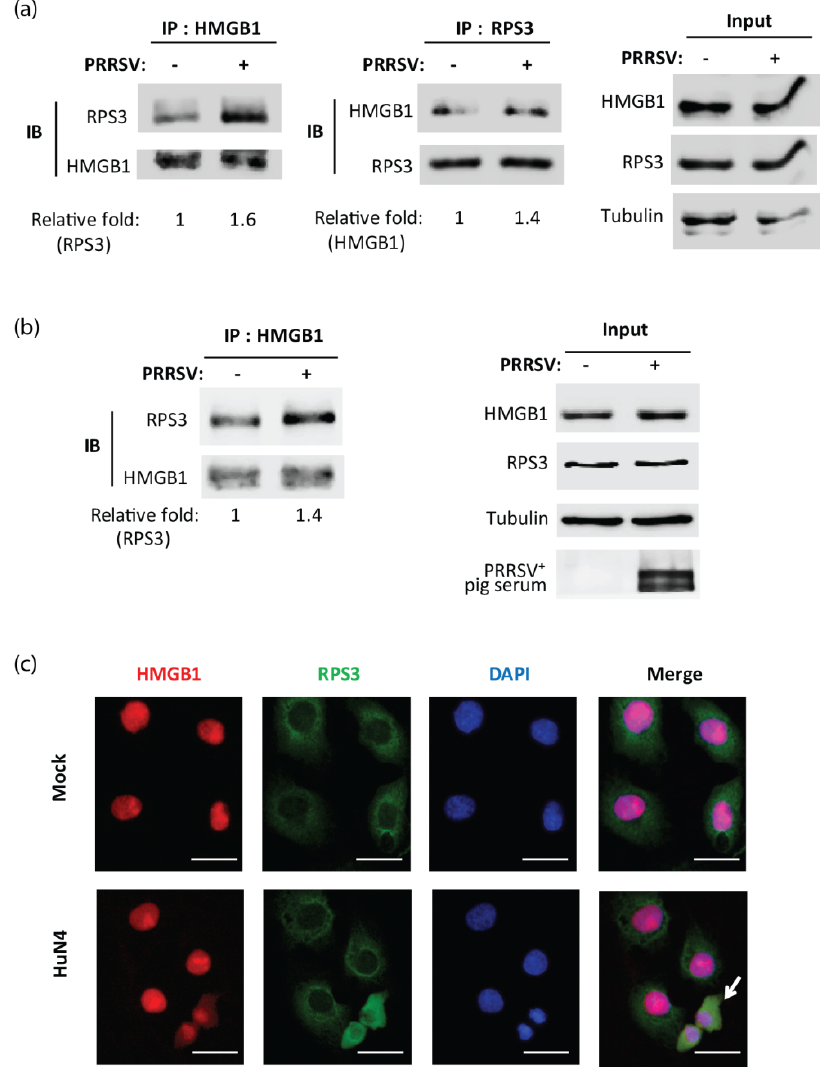
Figure 4. PRRSV increases HMGB1 binding to RPS3 in MARC-145 cells. MARC-145 cells were infected with HuN4 at an MOI of 1 for 6 h ( a ) and 24 h ( b ). The cells were harvested for IP with antibodies against HMGB1 or RPS3, followed by IB. Relative levels of RPS3 and HMGB1 are shown as folds below the images after normalization with HMGB1 or RPS3, respectively, in a densitometry analysis. The input was also included in IB. PRRSV + pig serum was used for detecting PRRSV infection. ( c ) Immunofluorescence assay (IFA) shows the co-localization of HMGB1 and RPS3. MARC-145 cells were infected with HuN4 at an MOI of 1 and, 24 h later, were fixed for IFA with antibodies against HMGB1 (red) and RPS3 (green). DAPI staining of nuclear DNA is also shown (blue). Arrow points to the cell showing HMGB1-RPS3 co-localization. Bar in images denotes 25 μm.